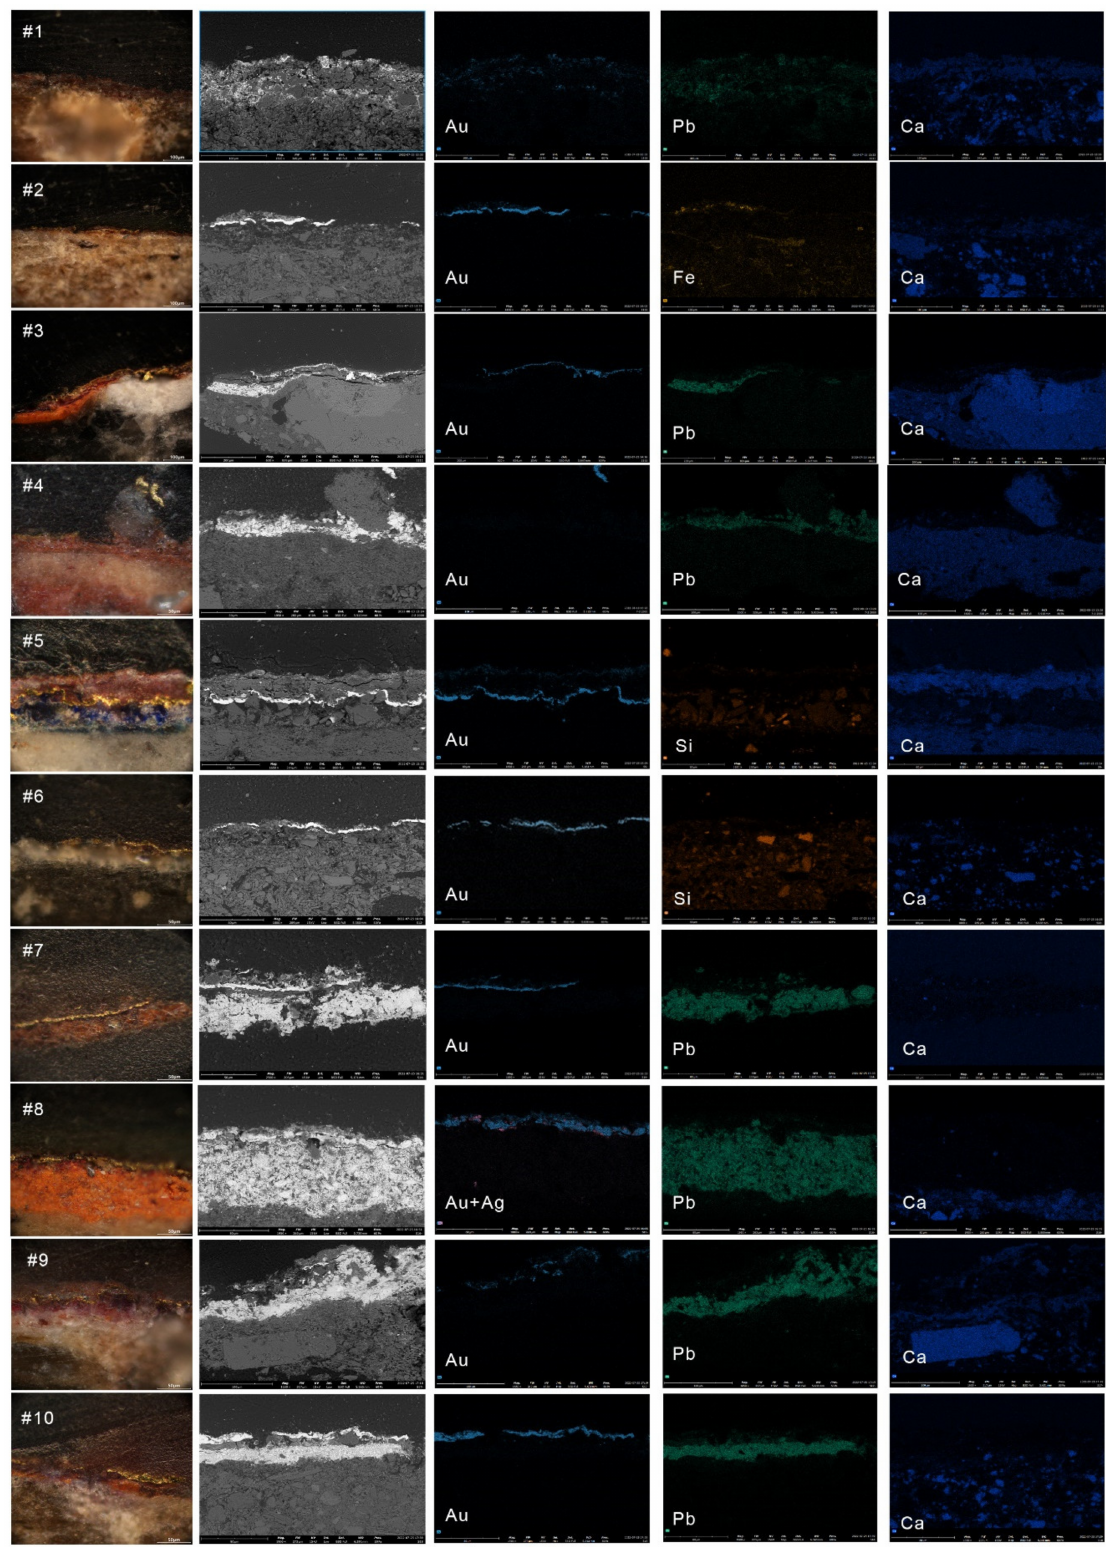
Figure 3. Images of the cross-sections and their element mapping. Each row represents a sample; The first column showing an optical micrograph of the observation area, the second column showing a BSE image, followed by three columns showing the distribution of elements for each representative element of the